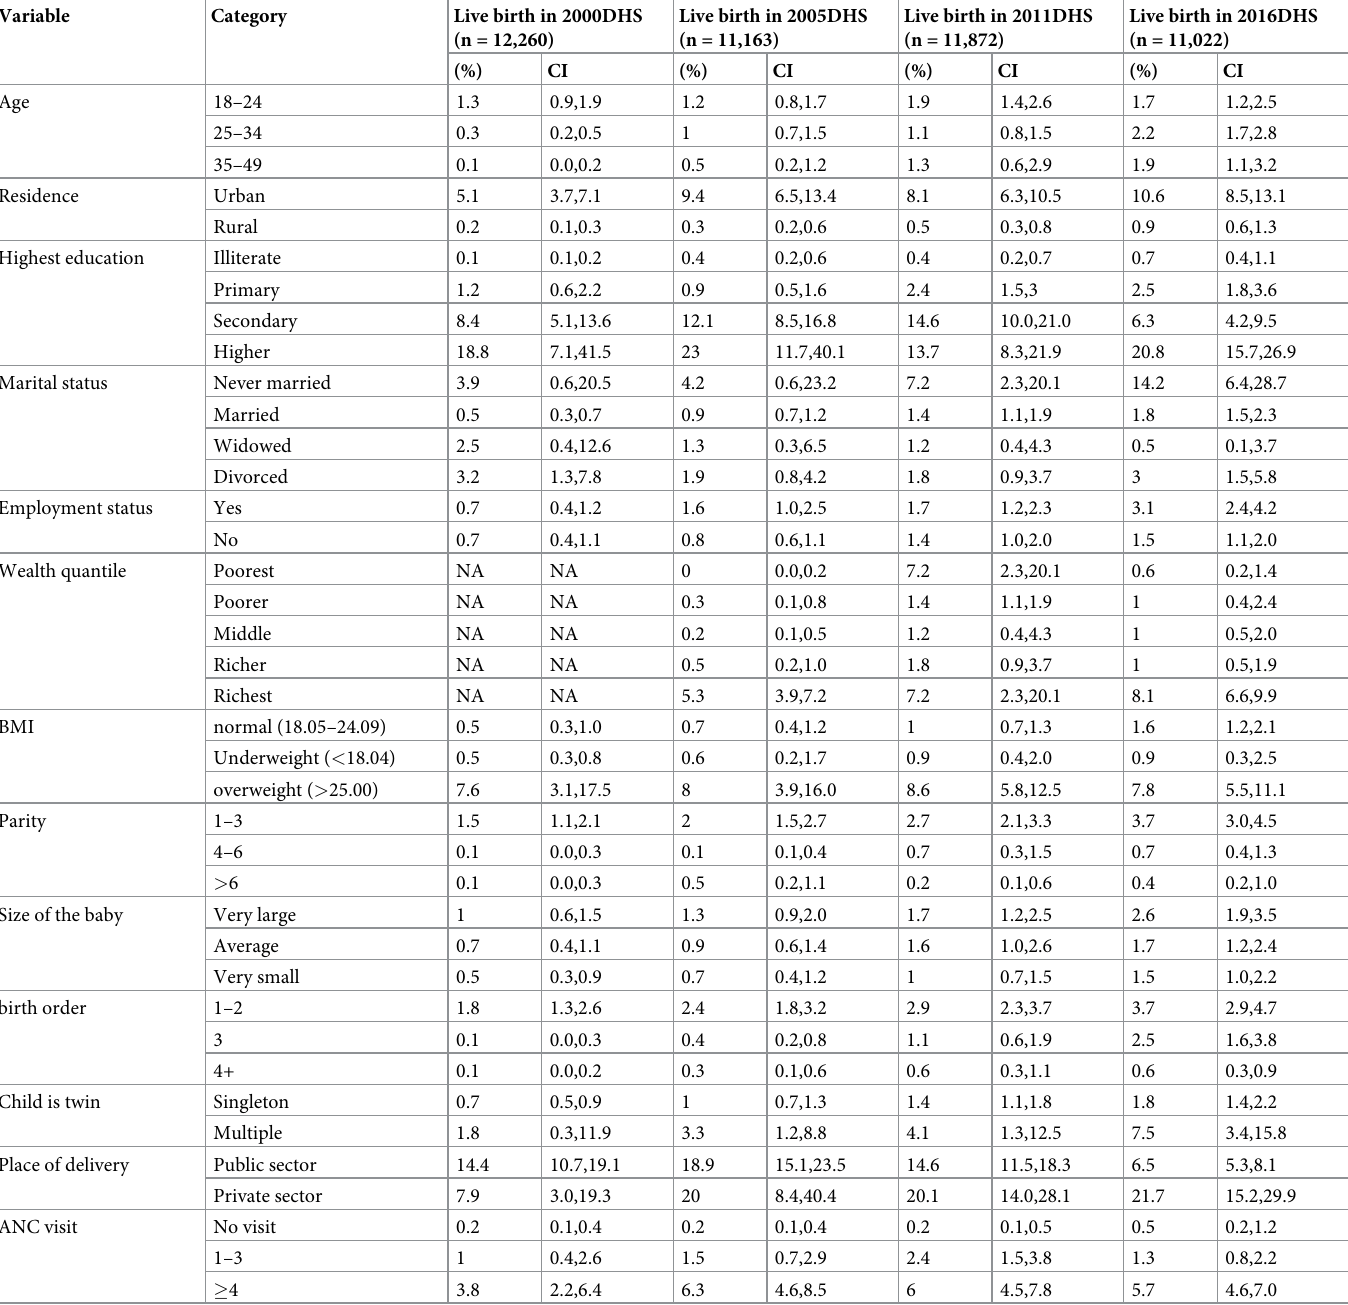
Table 3. The magnitude of cesarean section rate across the various characteristics of the respondents in Ethiopia, finding from 2000 to 2016. Variable